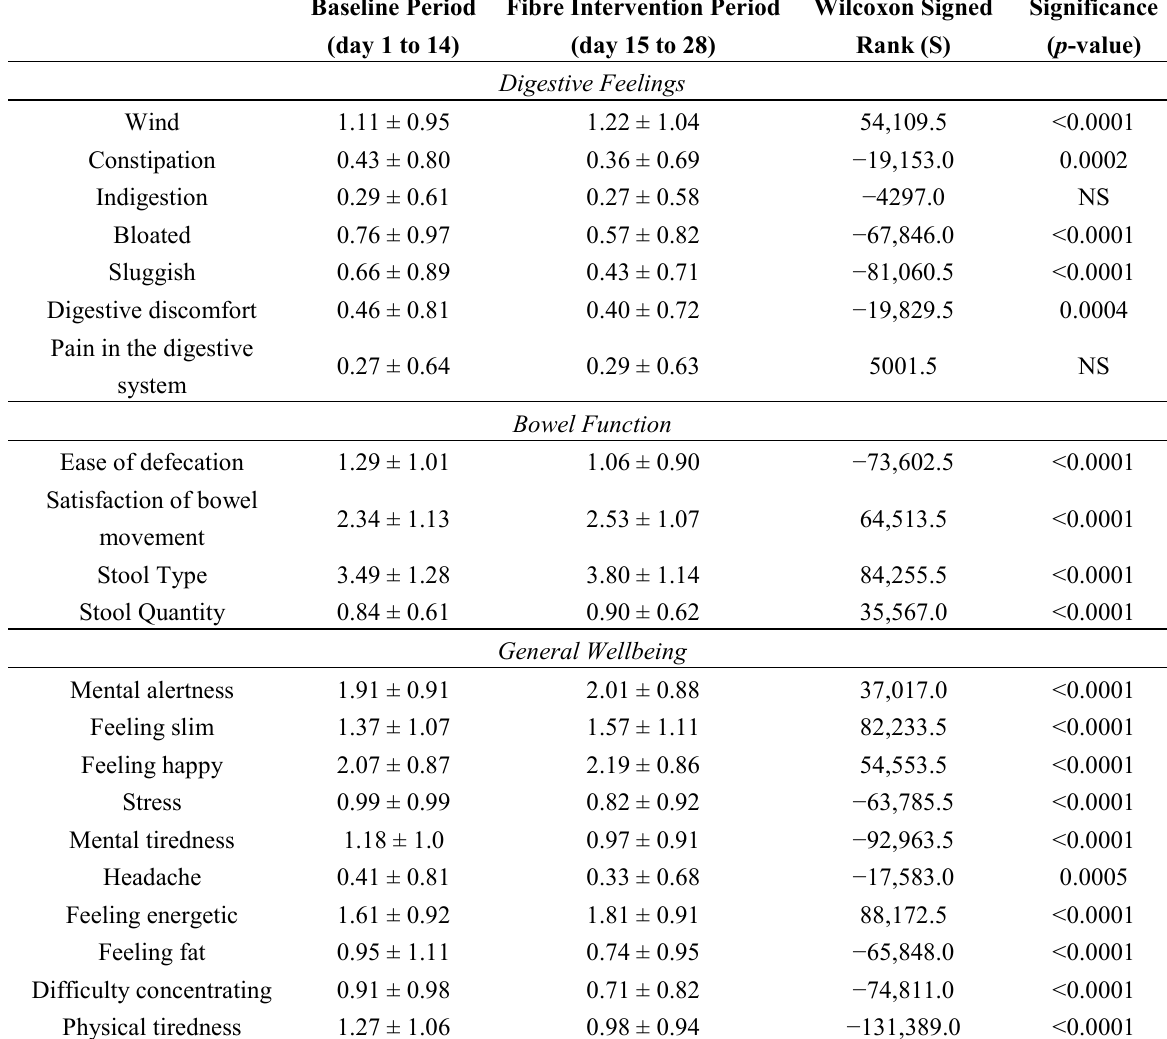
Table 2. Digestive Feelings 1 , Bowel Function 2 and General Wellbeing 1 : Summary statistics for the daily Likert scale scores provided across each 14 day period (153